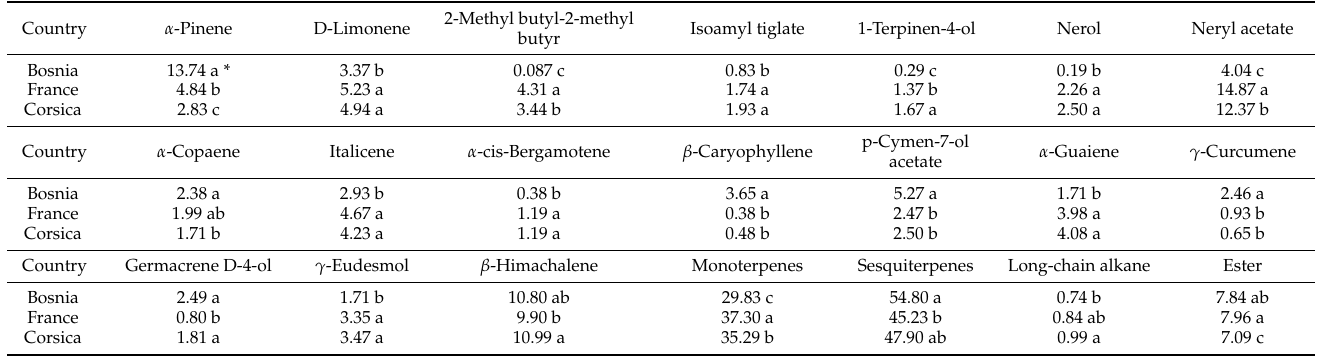
Table 6. Mean H. italicum concentration (%) of α -pinene, D-limonene, 2-methyl butyl-2-methyl bu- tyrate, isoamyl tiglate, 1-terpinen-4-ol, nerol, neryl acetate, α -copaene, italicene, α -cis-bergamotene, β -caryophyllene, p-cymen-7-ol acetate, α -guaiene, γ -curcumene, ger-macrene D-4-ol, γ -eudesmol, β -